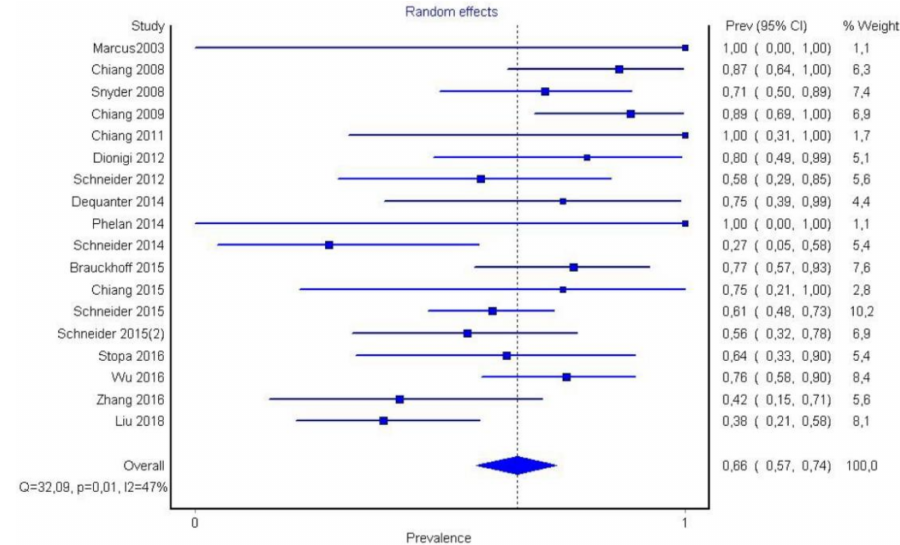
Figure 2. Forest plot P1.